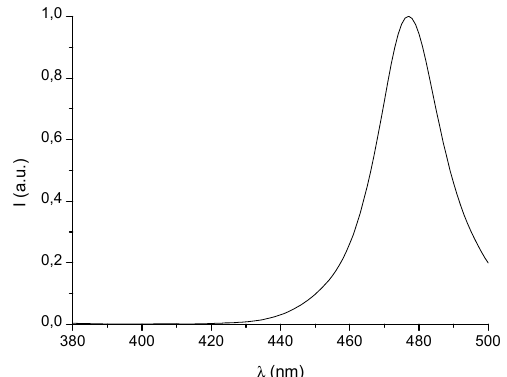
Figure 1. The emission spectrum of a blue LED centered at 477 nm (SmartLite Focus from Dentsply Sirona Germany).